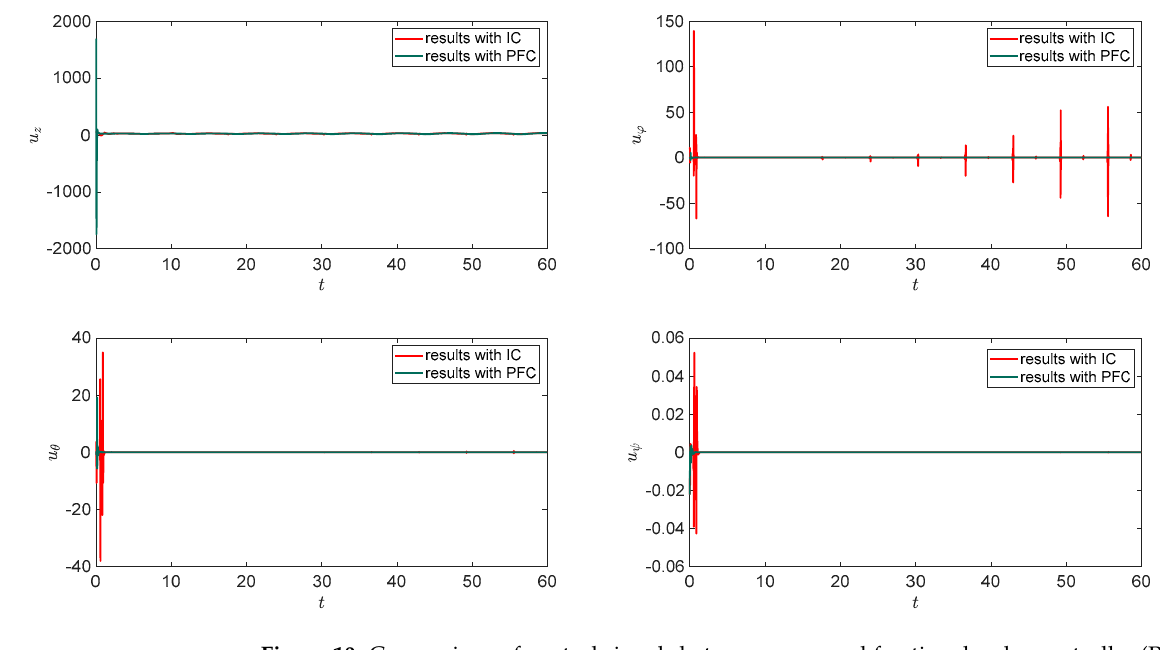
Figure 9. Comparison of system state time history between proposed fractional order controller (PFC) and integer order controller (IC).